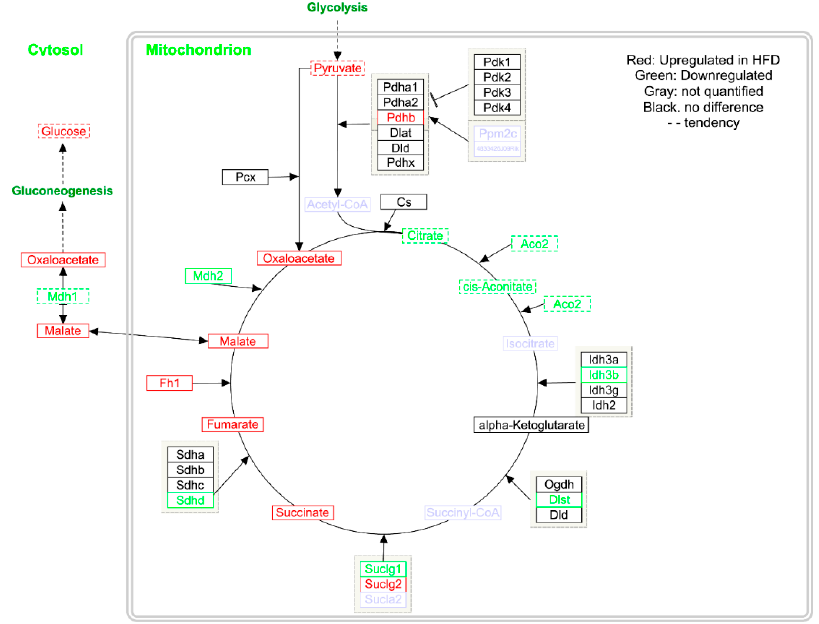
Figure 4. The tricarboxylic acid (TCA) cycle showing differences in gene expression and metabolite abundances in mouse liver. Upregulated in HFD are shown in red, and those that were downregulated are shown in green, genes and metabolites not quantified are shown in gray. Data is shown in Table 1 and Table